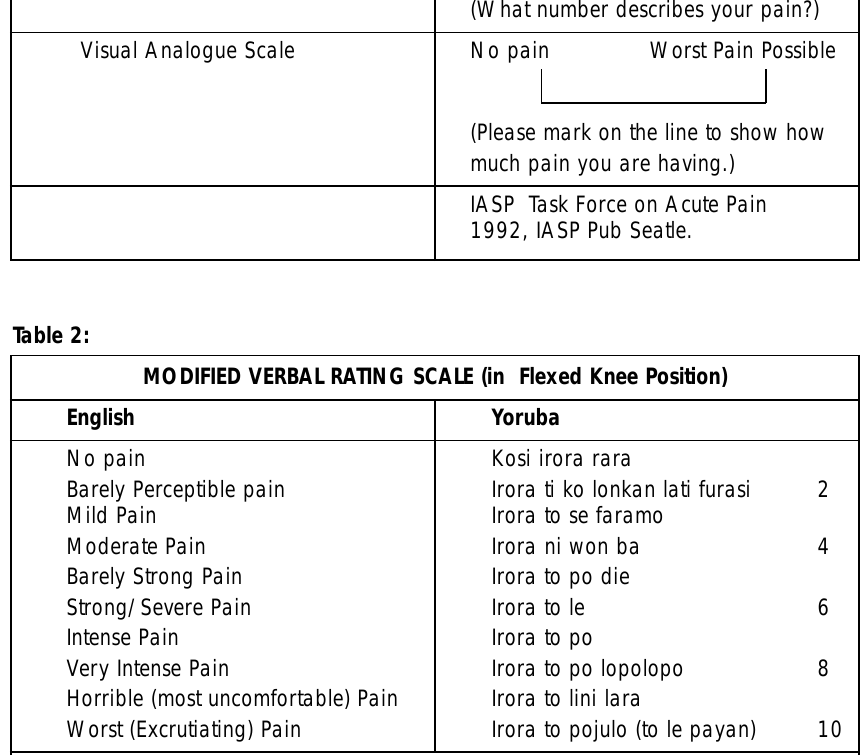
TECHNIQUES FOR GRADING PAIN Technique